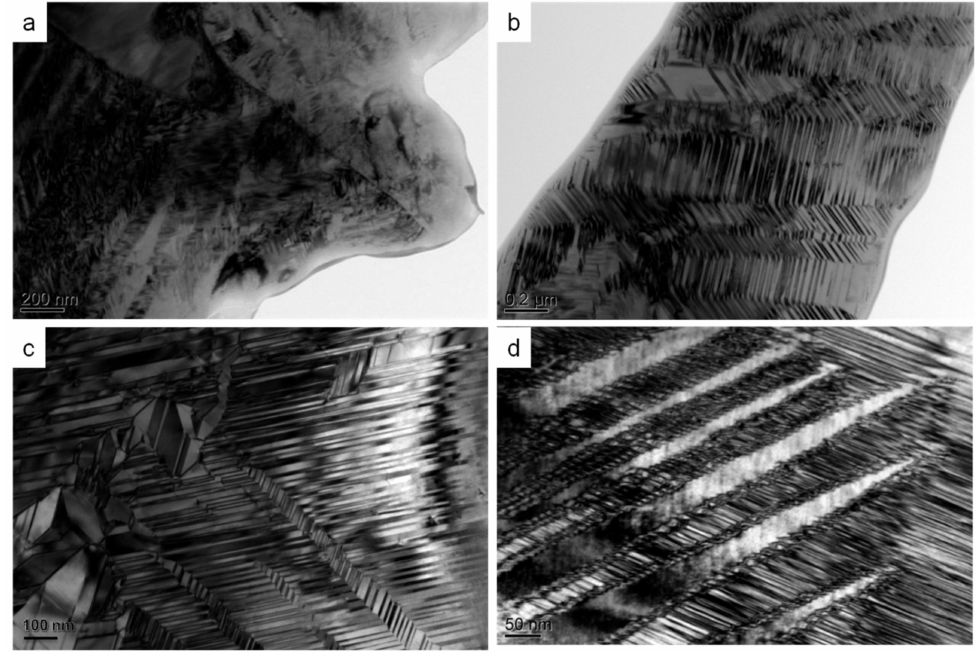
Figure 3. Overlapping twins in bulk Ti 3 Sn sample. ( a ) Extensively distributed twins; ( b ) lamellar nano-twins; ( c ) multiple twins distributed with 120 ◦ crossover; ( d ) stepped twins and inner lamellar twins.